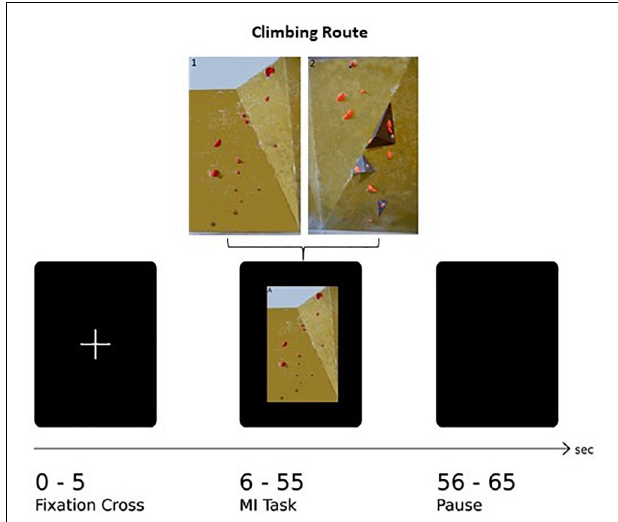
FIGURE 1 | Illustration of one experimental trial: After the presentation of a fixation cross (5 s) the image of the climbing route (exemplarily Route 1: easy) is presented (50 s) followed by a rest period (10